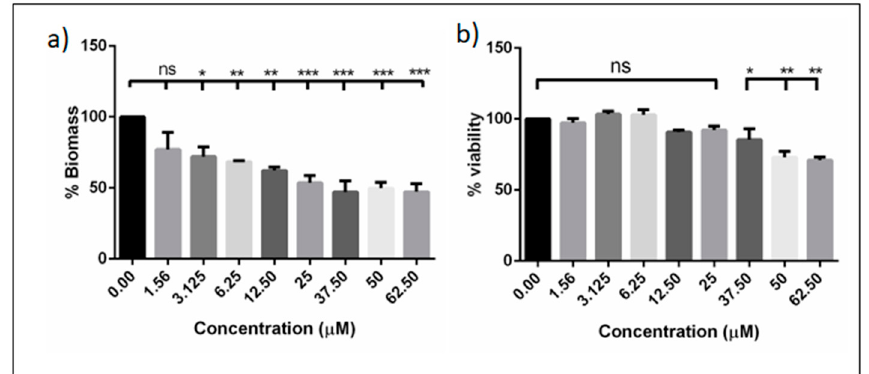
Figure 5. Effect of DMTU on preformed biofilms. ( a ) Dose-dependent reduction of biomass when treated with different concentrations of DMTU; ( b ) effect of DMTU on cell viability of pre-formed biofilms. * denotes p ≤ 0.05, ** denotes p ≤ 0.01 and *** denotes p ≤ 0.001, ns denotes > 0.05.